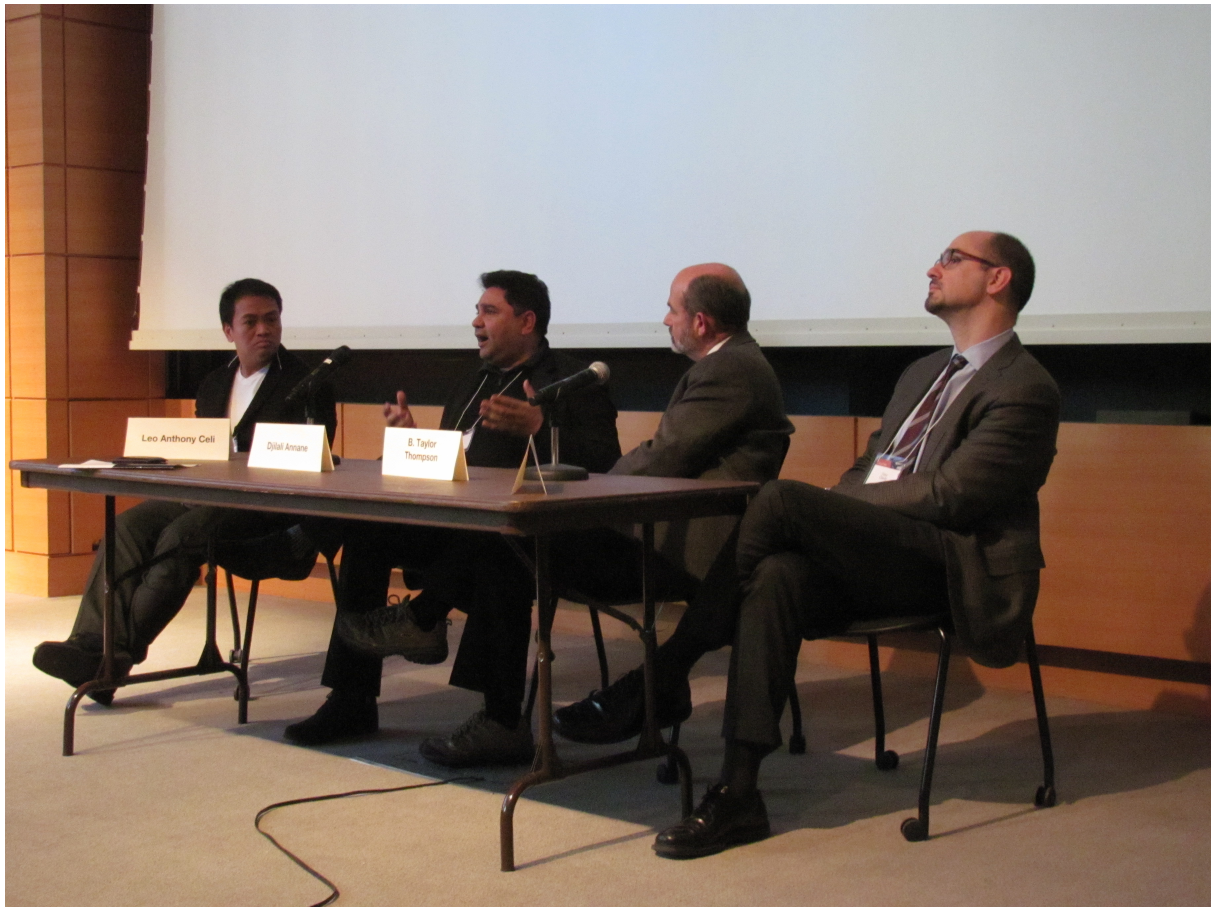
Figure 4. Physician culture panel. Photo credit: Andrew